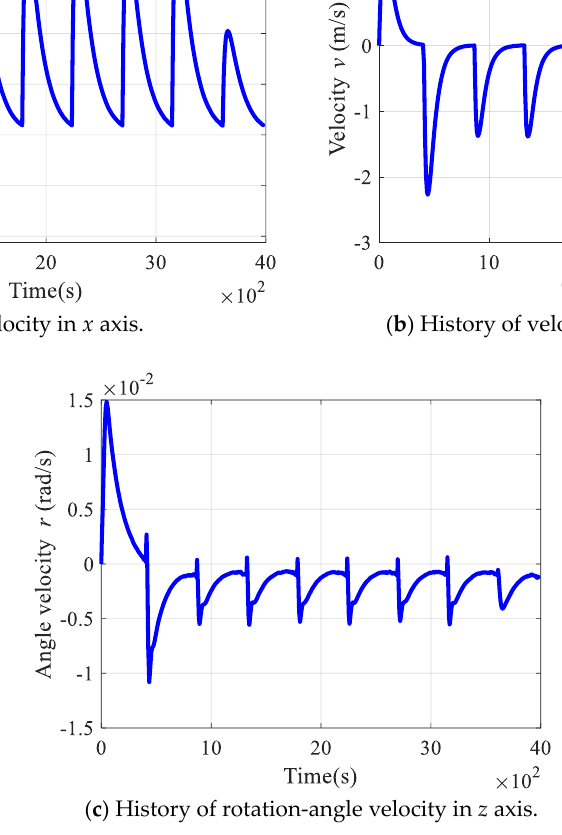
Figure 10. Histories of velocities of controlled AUSV.